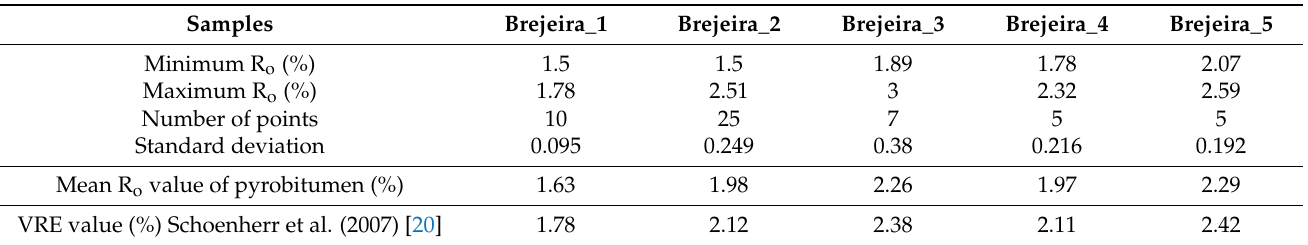
Table 3. Results of organic matter maturation based on vitrinite reflectance analysis from 5 samples (Brejeira 1, 2, 3, 4, and 5).